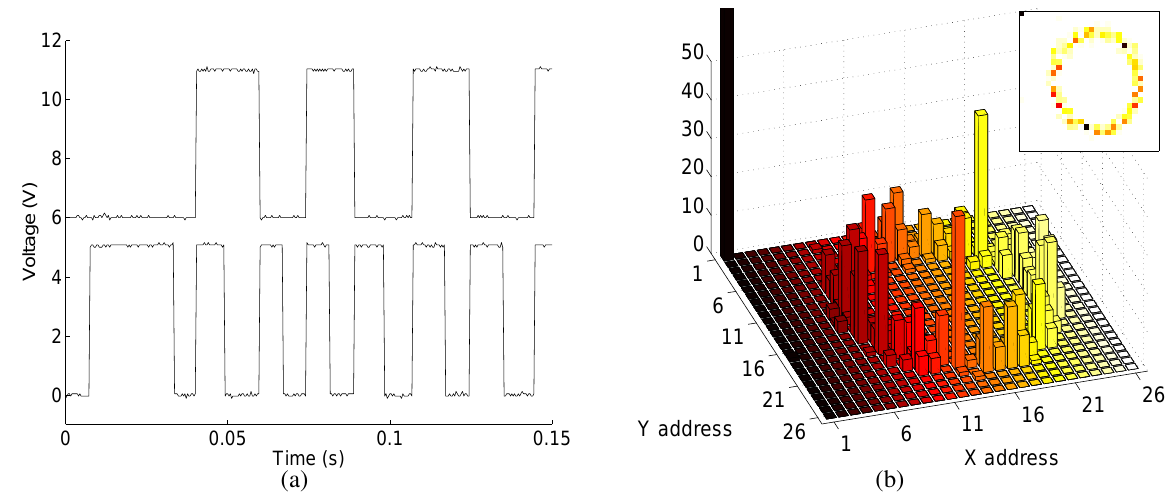
Figure 9 . (a) Output of least significant bit (bottom trace) and second-least significant bit (top trace, displaced by 6V) of the ’X’ address in response to a target moving from right to left. (b) Histogram of the addresses measured from the sensor’s address encoders in response to a target moving on a circular